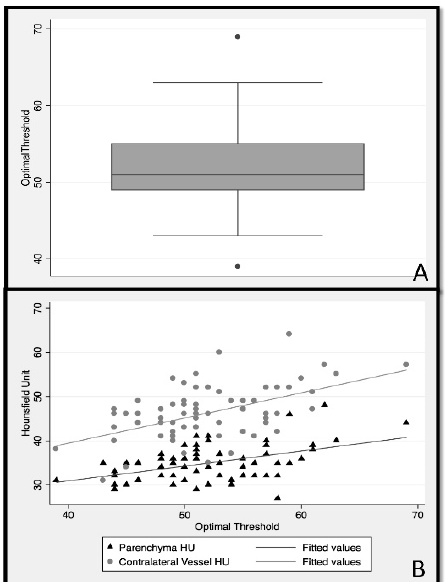
Figure 3. Panel ( A ) shows a box plot of the distribution of optimal thresholds that were calculated using ROC analysis comparing thrombus HU to normal tissue (parenchymal + contralateral vessel). A wide distribution indicates that there is no single HU threshold that is optimal to discriminate thrombus from normal tissue. Panel ( B ) is a two-way scatter plot showing that contralateral HU and parenchyma HU predict optimal HU threshold similarly.